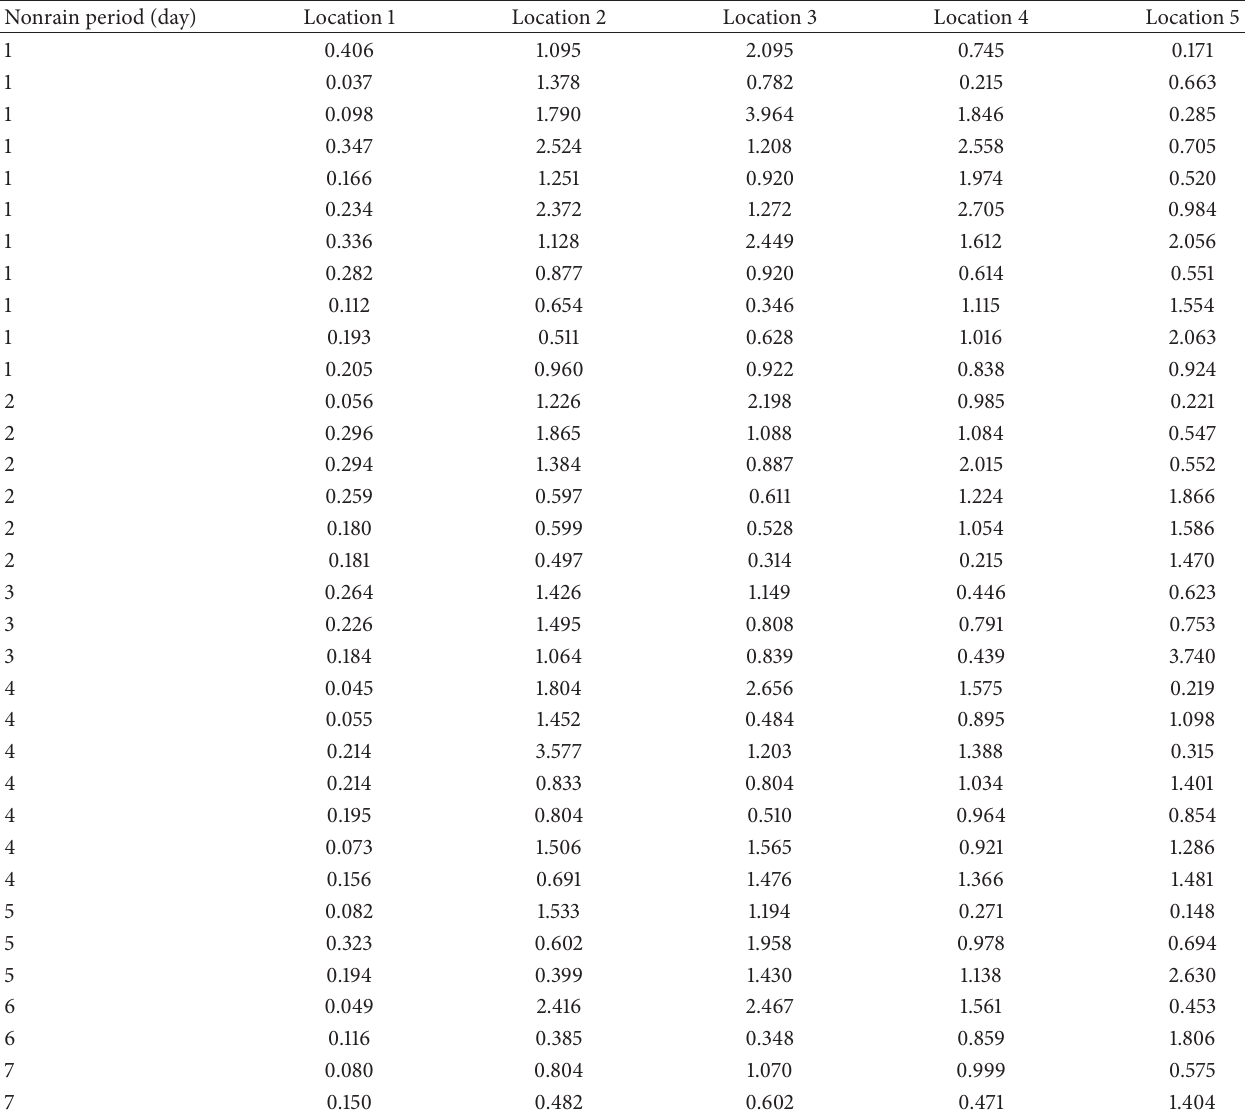
Table 2: The record of dust accumulation in different locations.